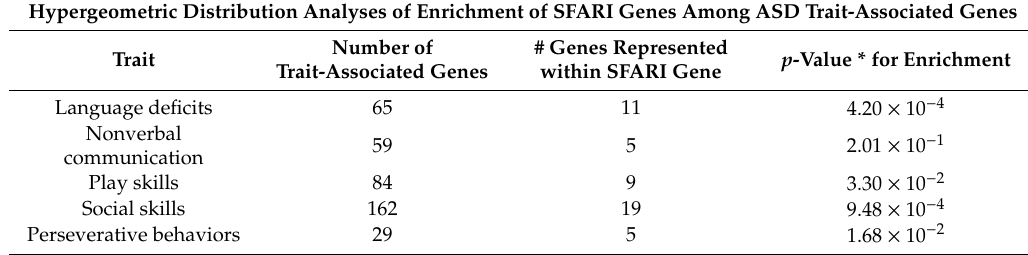
Table 2. Hypergeometric distribution analyses of trait-associated genes and SFARI